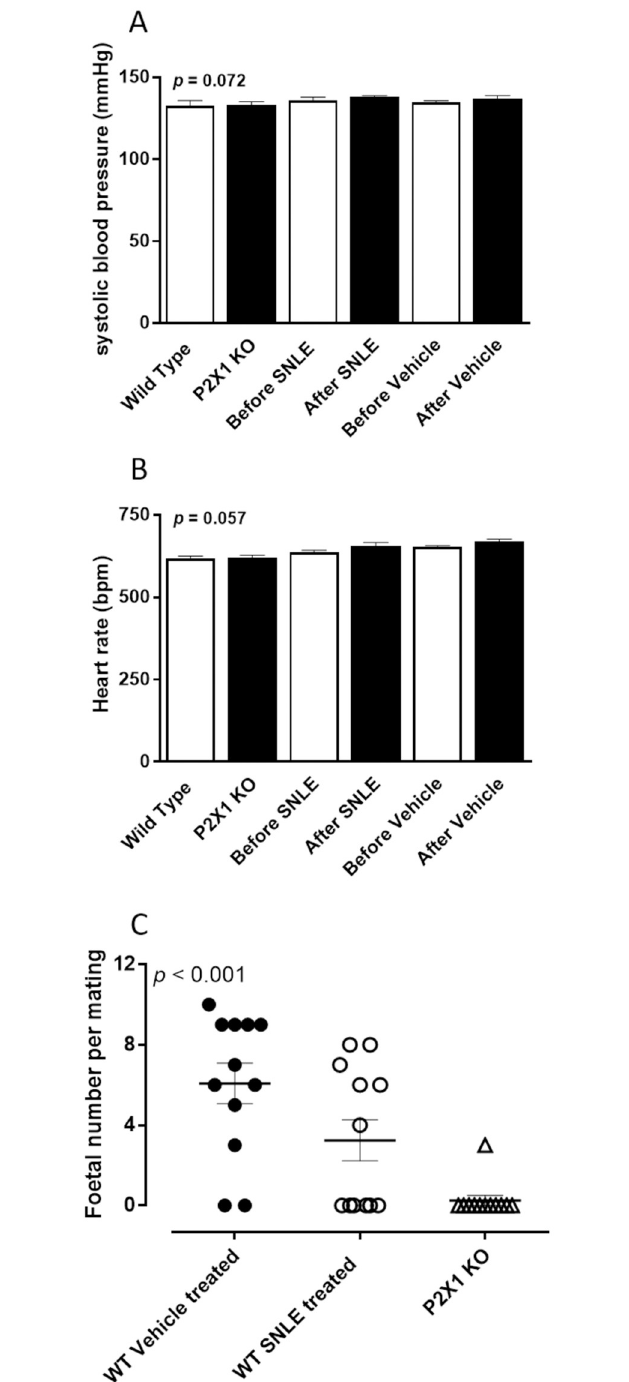
Fig 3. Effect of stinging nettle leaf extract or P2X1-purinoceptor deletion on resting cardiovascular parameters and male fertility. Mean resting (A) systolic blood pressure (mmHg) and (B) heart rate (bpm) measured by the tail cuff method in untreated age matched wild-type (n = 6) and P2X1-purinoceptor knockout (KO) (n = 6), and wild-type male mice, before and after daily oral dosing with stinging nettle leaf extract (SNLE) (100 μ l of 500 mg/ml) or vehicle (100 μ l of 20% ethanol), where n = 6 for each treatment variable. Columns represent the mean systolic blood pressure (A) or heart rate (B) over 5 consecutive days prior to the commencement of treatment or 5 consecutive days after the commencement of treatment. Error bars represent SEM. ANOVA p -values were determined by two-way repeated- measures ANOVA and represent the probability of genotype or treatment causing a significant change in systolic